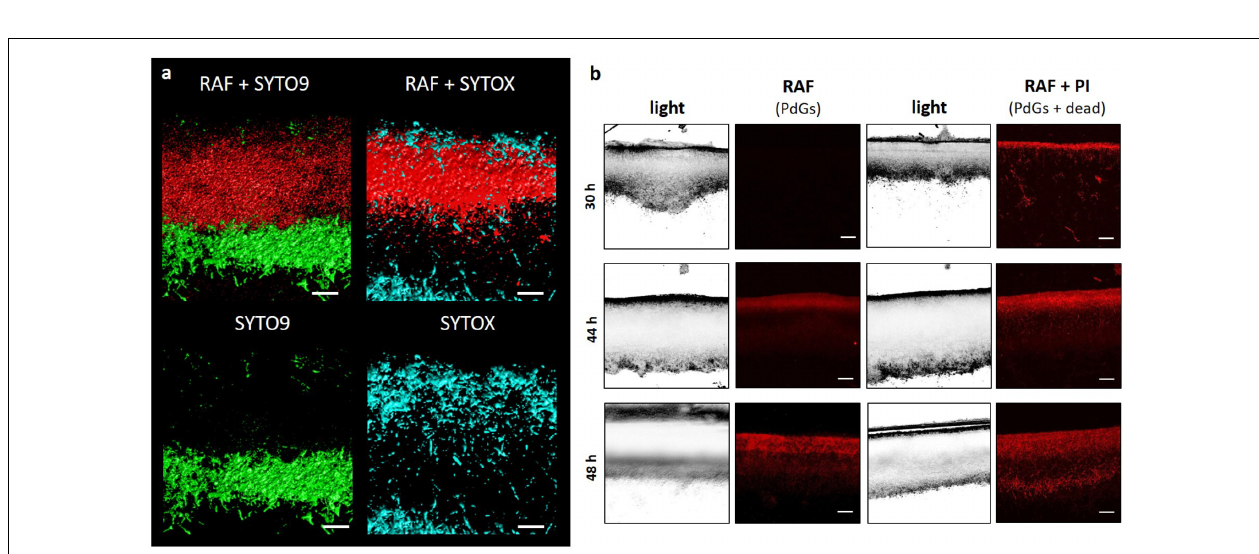
FIGURE 3 | Localization of the production of prodiginines in the dying zones of the S. coelicolor culture. (a) Fluorescence confocal micrographs (3D reconstruction) of two transverse sections of an S. coelicolor M145 culture grown for 40 h on R2YE agar plates. Left panel: RAF (red-colored) and staining of viable filaments (green-colored, SYTO9). Right panel: RAF (red-colored) and staining of dying filaments (blue-colored, SYTOX). Bar, 20 µ M. (b) Visualization of the red fluorescence associated with PdG production (RAF) and propidium iodide staining (PI). Bar, 20 µ M.